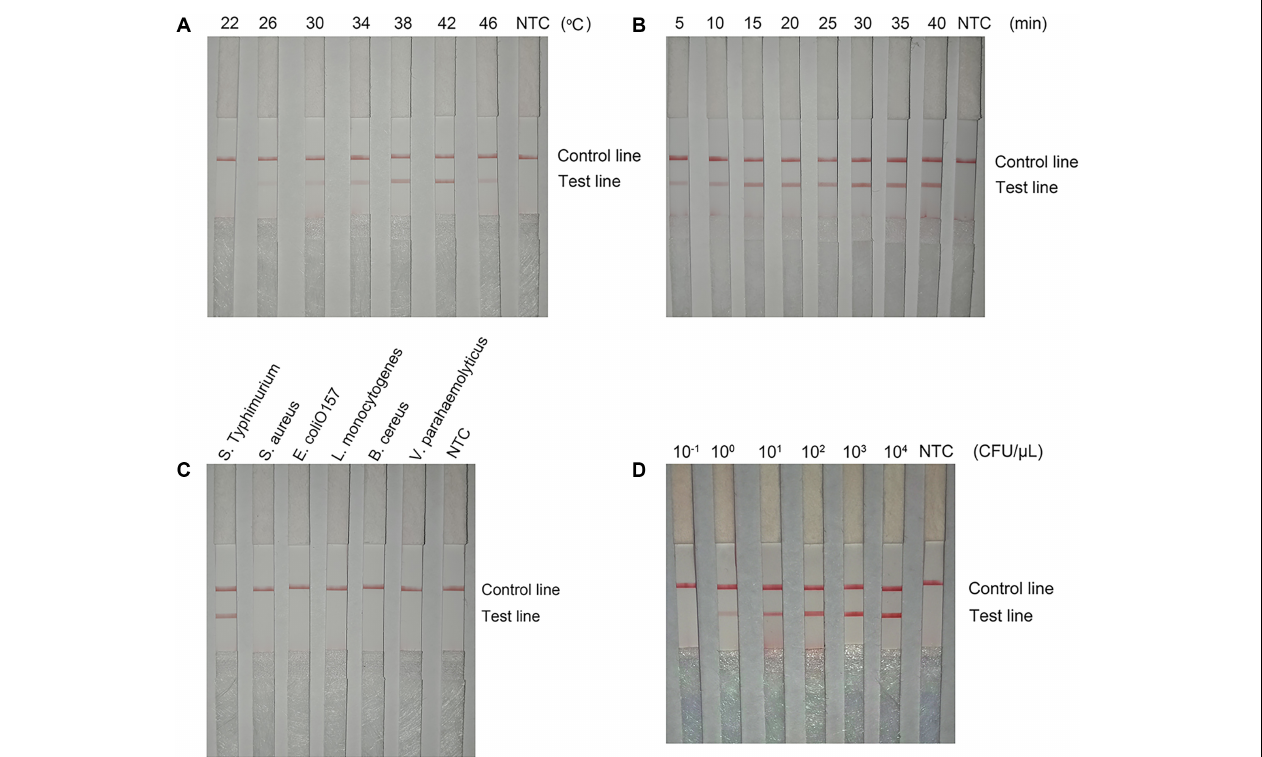
FIGURE 9 | The performance of the optimized primer–probe set in RPA–LFS. (A) Optimal reaction temperature of the RPA–LFS test. The image shows the LFS results of RPA amplifications under different temperatures. The temperatures under which the RPA reactions were performed are indicated on top of each strip. The amplification template was Salmonella enterica serotype Typhimurium ( S. Typhimurium). The NTC strip is the no-template control that performed at 37 ◦ C. The positions of the control and test lines are indicated on the right of the image. (B) Optimal reaction time of the RPA–LFS test. The image shows the LFS results of RPA amplifications with different times. The time for which the RPA reactions were performed are indicated on the top of each strip. The amplification template was S. Typhimurium. The NTC strip is the no-template control that performed for 40 min. The positions of the control and test lines are indicated on the right of the image. (C) Detection specificity of the optimized primer–probe set. Specificity assay of RPA–LFS was conducted with different bacterial templates. The species of the bacteria are indicated on the top of each strip. The NTC strip is the no-template control. The positions of test and control lines are marked on the right of the strip image. The reactions were performed at 42 ◦ C for 30 min. (D) Detection limit of the RPA–LFS test. The image shows detection limit of the RPA–LFS system. The image shows the LFS results of RPA amplifications with different CFU of S. Typhimurium. The amounts used in the RPA reactions are indicated on top of each strip. The NTC strip is the no-template control. The reactions were performed at 42 ◦ C for 15 min. The test line and control lines are marked on the right side of the image.